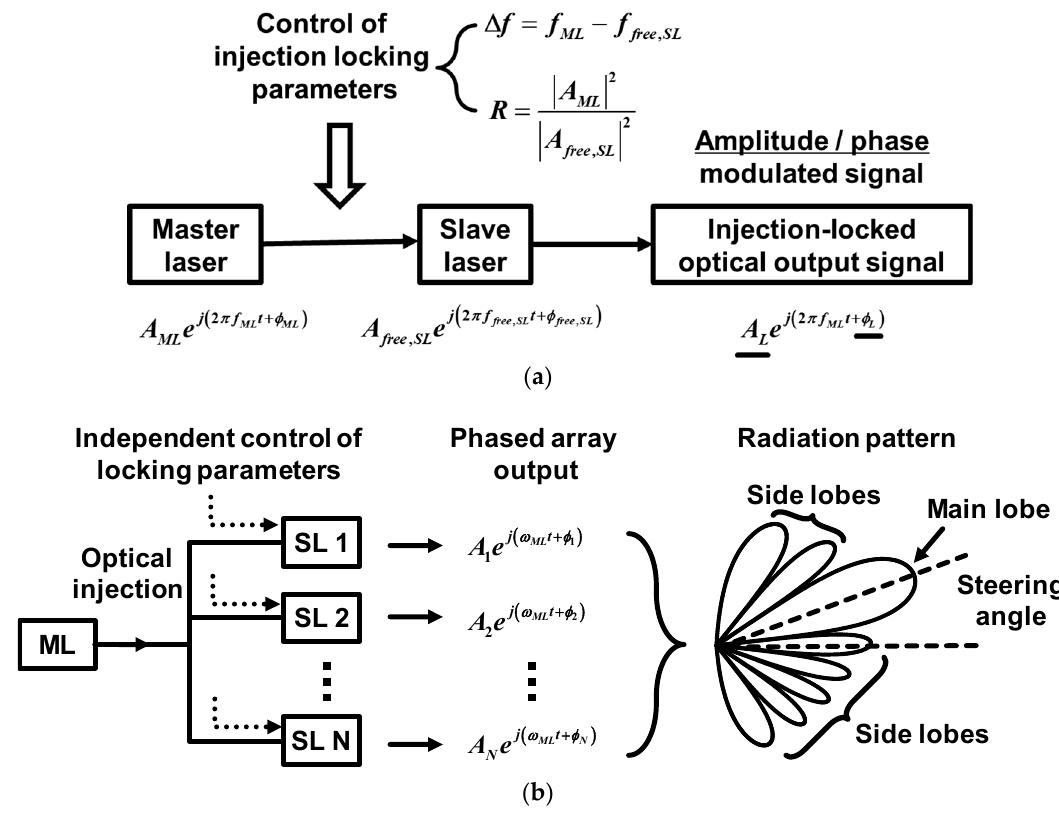
Figure 1. (a) Schematic of the optical amplitude/phase control based on the optically injection ‐ locked Figure 1. ( a ) Schematic of the optical amplitude / phase control based on the optically injection-locked (OIL) laser. (b) Schematic of the active optical phased array (OPA) based on OIL lasers. OIL ‐ based (OIL) laser. ( b ) Schematic of the active optical phased array (OPA) based on OIL lasers. OIL-based OPA OPA (ML: master laser, SL: slave laser). (ML: master laser, SL: slave